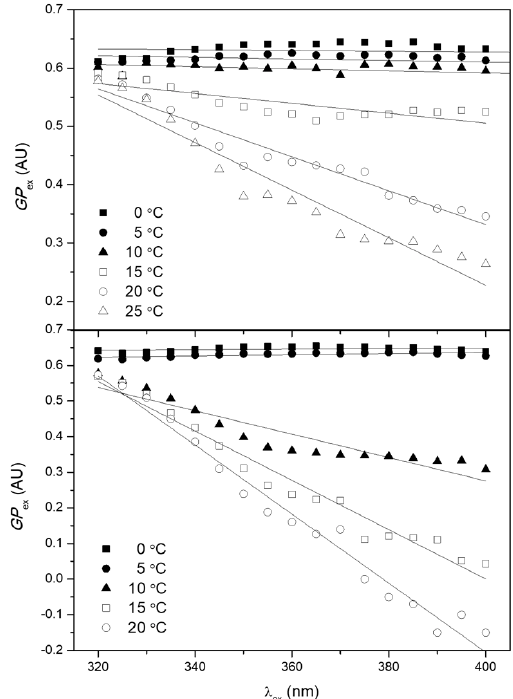
Figure 3. GP ex values as a function of the λ ex for POPE:POPG (3:1, mol/mol) liposomes at different temperatures. ( Top ) blank liposomes; ( Bottom ) liposomes incubated with 5 nM G1OLO-L 2 OL 2 .